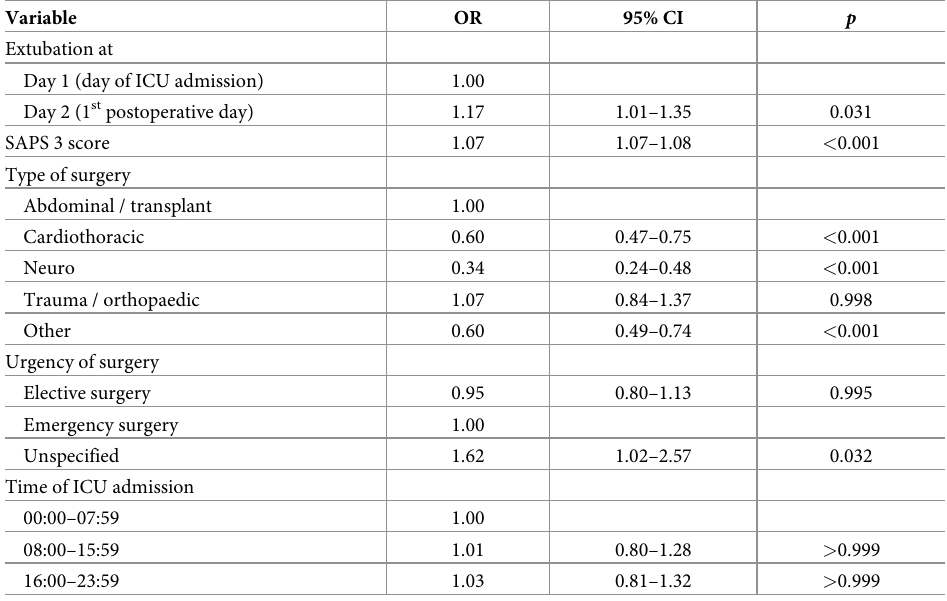
AUC = 0.817. CI = confidence interval, ICU = intensive care unit, OR = odds ratio, SAPS 3 = Simplified Acute Physiology Score